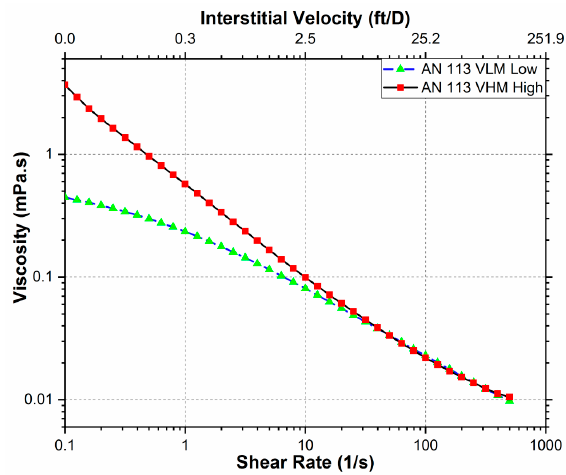
Figure 9. The bulk rheology of AN 113 VLM and AN 113 VHM at a concentration of 1000 ppm and salinity of 5000 ppm.